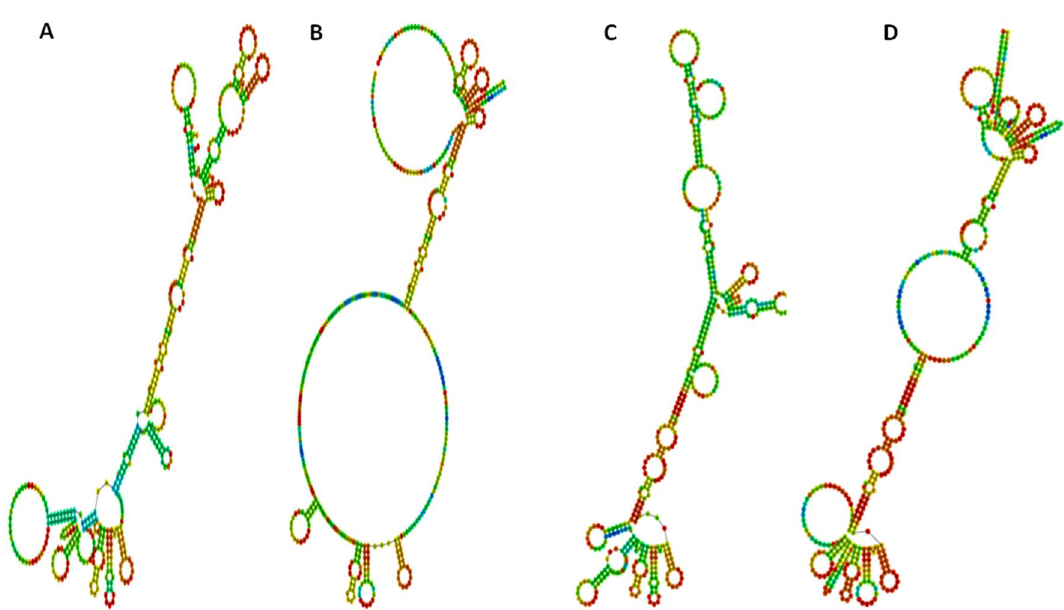
Figure 8. The prediction of BBD129 mRNA secondary structure variations using RNAfold server. ( A ) The BBD129 -TA mRNA secondary structure is based on the minimum free energy. ( B ) Centroid-free secondary structure of BBD129 -TA mRNA. ( C ) The BBD129 -GG mRNA secondary structure is based on minimum free energy. ( D ) Centroid-free secondary structure of BBD129 -GG haplotype